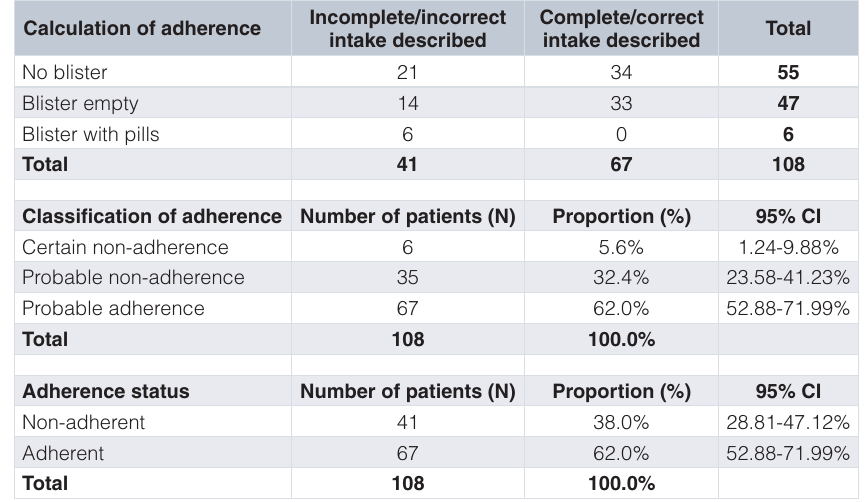
Table 5. Adherence to currently used ACT treatment (ASAQ) for uncomplicated